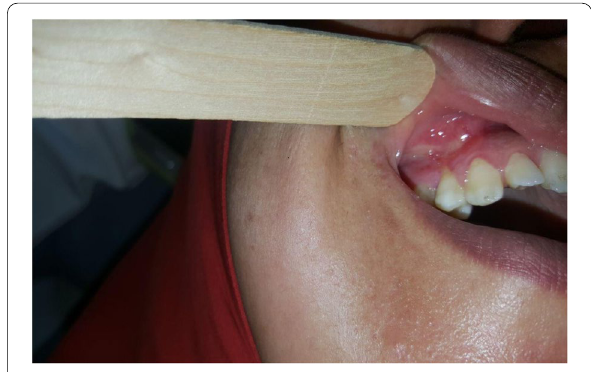
Fig. 3 Postoperative view showing healing of the